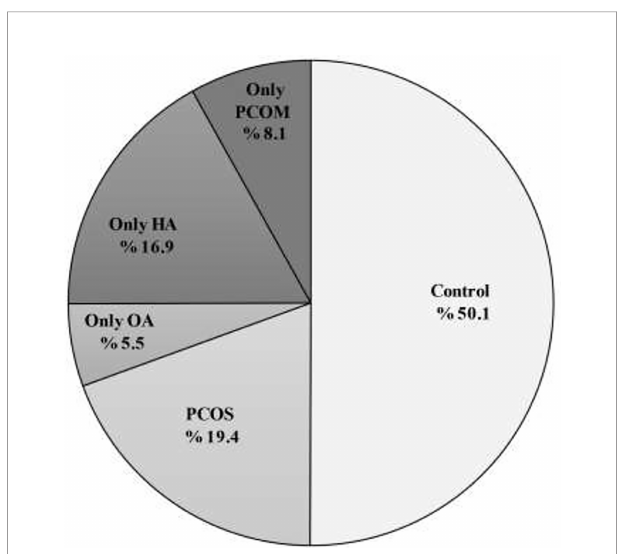
FIGURE 1 | Distribution (%) of PCOS women patients with phenotypes A, B, C, and D and also women with only OA, HA, and PCOM with the control group. PCOS, Polycystic ovary syndrome; OA, oligo anovulation; HA, hyperandrogenism. PCOM, polycystic ovaries